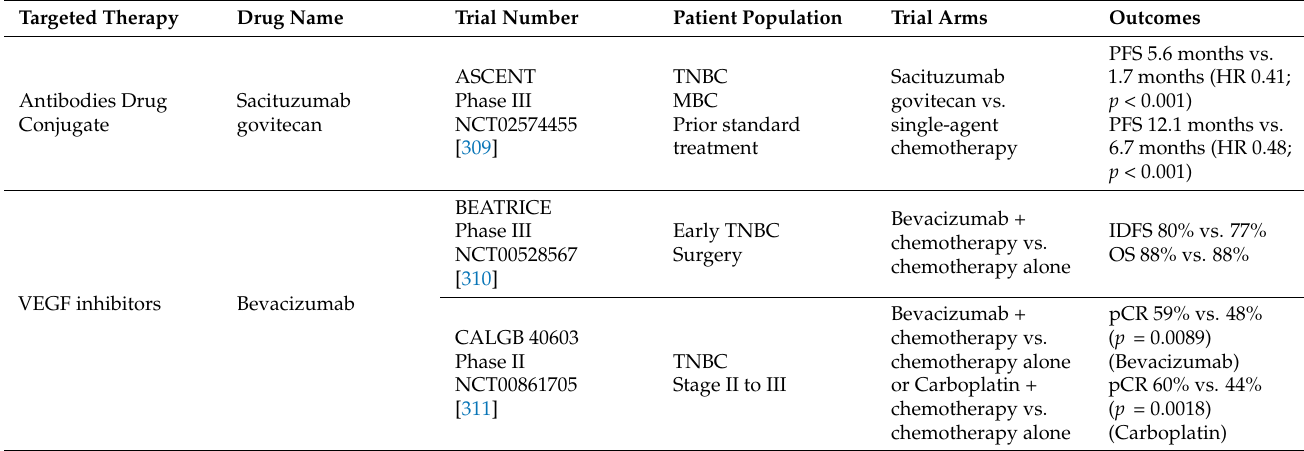
Table 3. Most recent completed clinical trials on emerging therapies for